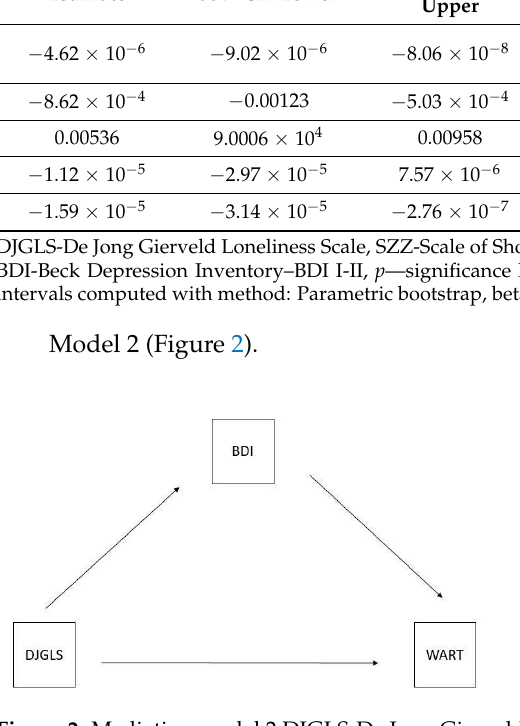
Figure 2. Mediation model 2 DJGLS-De Jong Gierveld Loneliness Scale, WART-Work Addiction Risk Test, BDI-Beck Depression Inventory–BDI I-II.